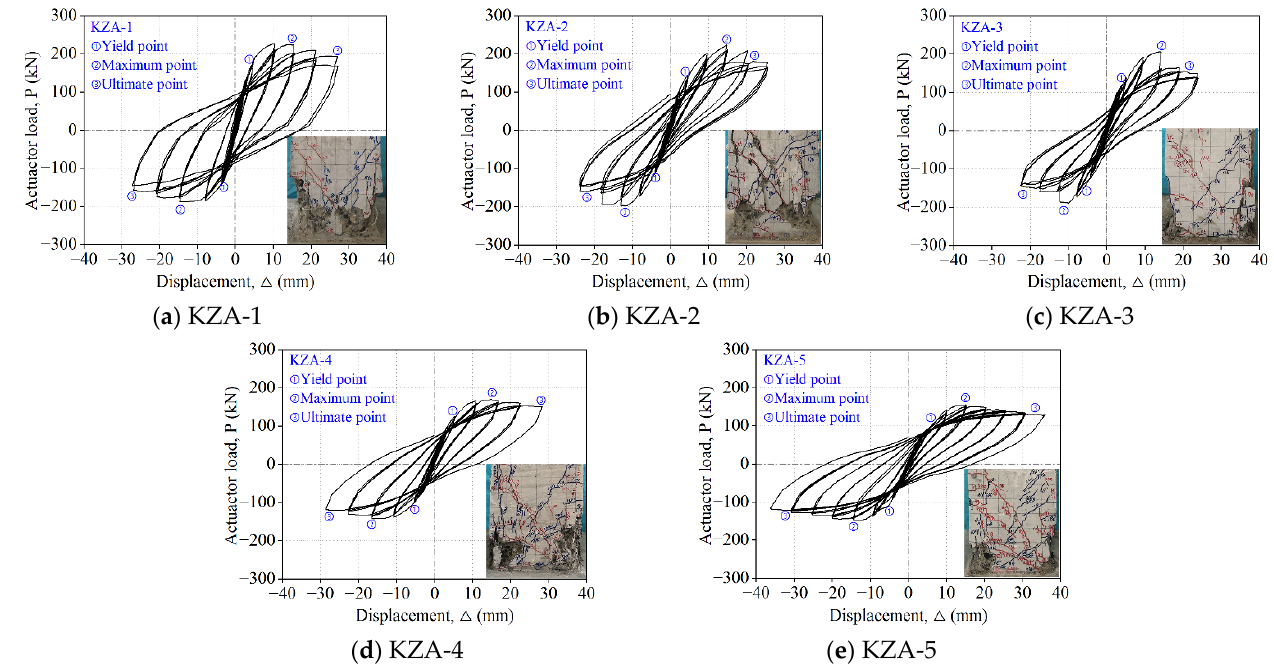
Figure 8. Hysteretic curves of specimens.